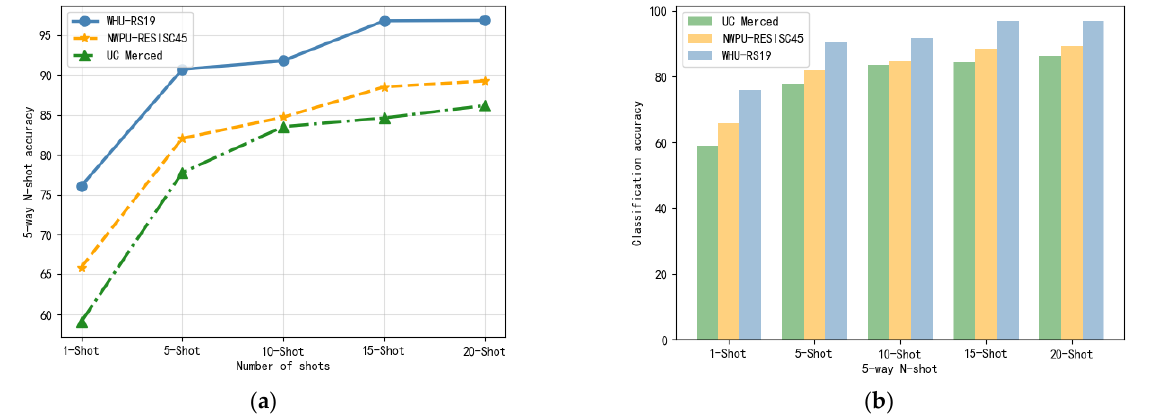
Figure 8. The effect of different shots on 5-way N-shot accuracy on UC Merced, NWPU-RESISC45, and WHU-RS19 datasets. ( a ) is the influence of different shots shown in the line chart, and ( b ) is the influence of different shots shown in the histogram.